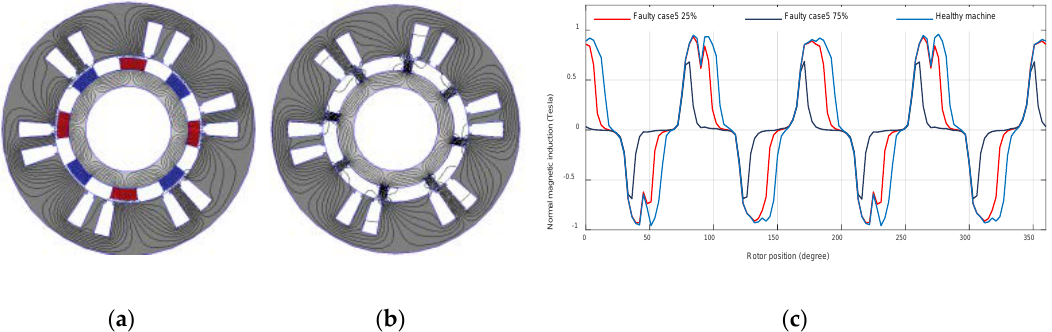
Figure 10. Faulty case 5: ( a ) Magnetic field under 25%; ( b ) magnetic field under 75%; ( c ) airgap magnetic flux density.